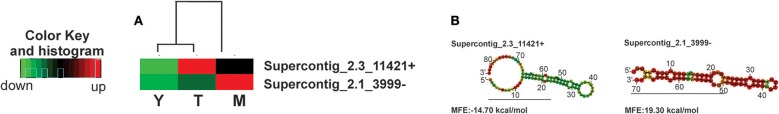
Heat map of microRNAs with the highest values of expression in the mycelium and transition and the predicted secondary structures. (A) Heat-map, (B) predicted secondary structure. Down-regulated microRNAs are shown in green and up-regulated microRNAs in red. (M)-Mycelium, (T)-Transition mycelium-to-yeast cells (Y) yeast. The secondary structure of the pre-microRNAs was predicted by the RNAFOLD database.